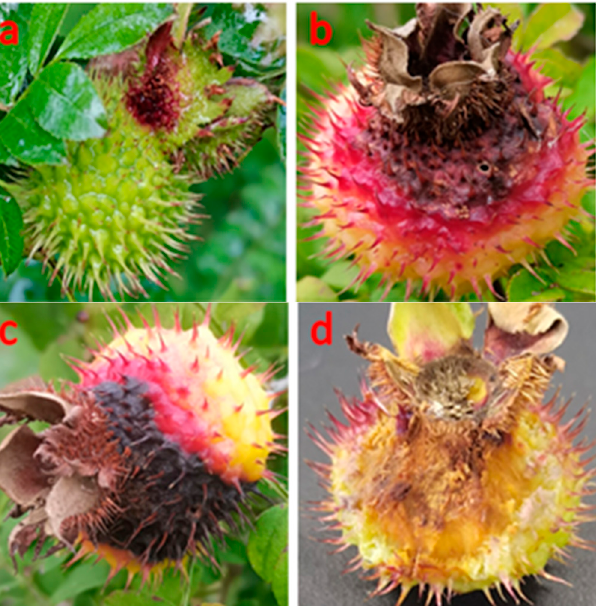
Figure 1. The early ( a ), middle ( b ), late ( c ), and internal fruit ( d ) symptoms of top rot in R. roxburghii fruits. R. roxburghii